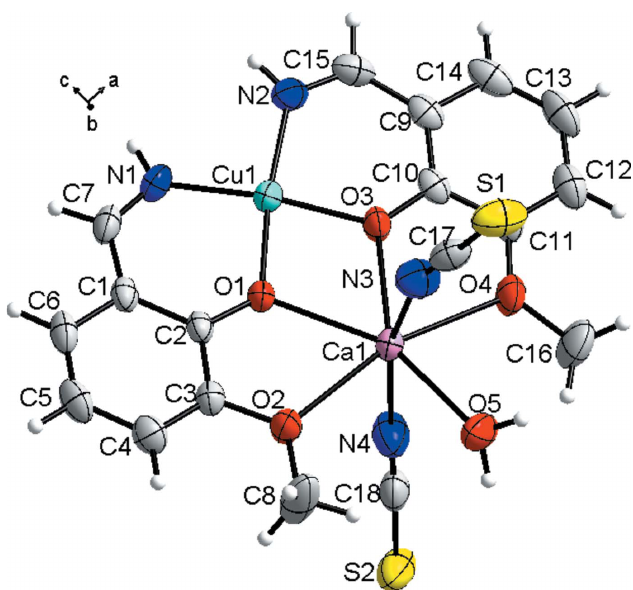
Figure 1 Molecular structure of the title compound, with the numbering scheme and displacement ellipsoids drawn at the 50% probability